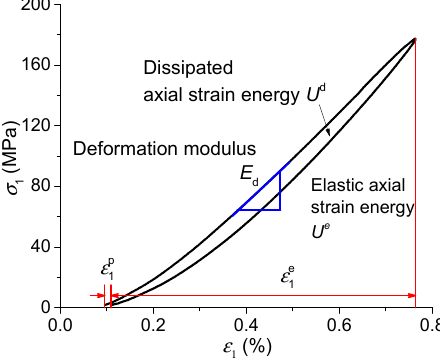
Figure 8. Illustration of the elastic and dissipated energy, deformation modulus, as well as the axial elastic and plastic strain based on a cycle from the axial stress-strain curves shown in Figure